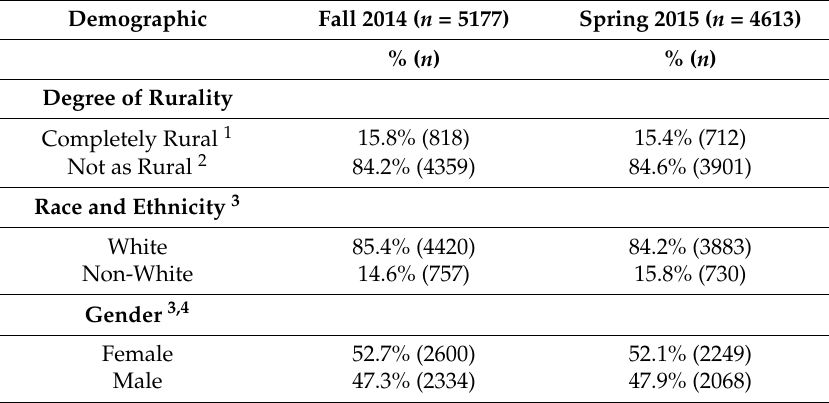
Table 1. Student demographics in the fall and spring semesters.